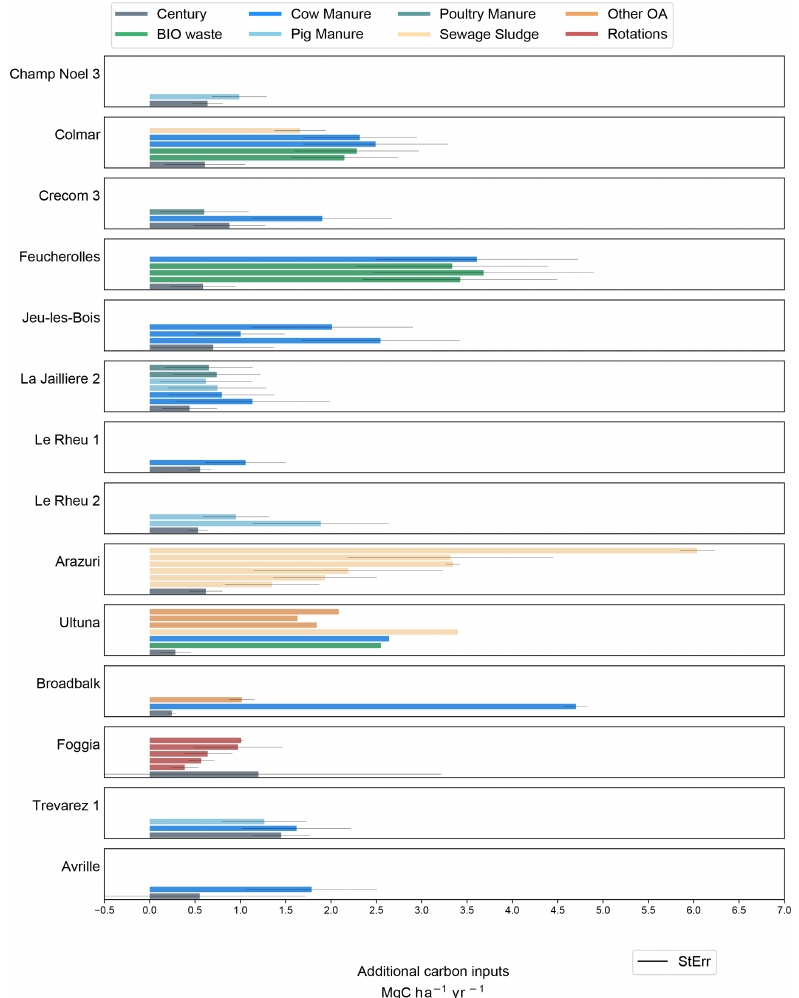
Figure 9. Additional modeled carbon inputs (MgCha − 1 yr − 1 ) to reach the 4p1000 (grey bars) compared to additional carbon input treatments (colored bars) at each experimental site. Additional carbon inputs for field trials are calculated as the sum of organic fertilizers and the delta carbon inputs from crop yields (compared to the control plot). Additional carbon treatments are separated into different categories: BIO waste: biowaste compost, green manure, green manure and sewage sludge, and household waste; Cow manure: cow manure and farmyard manure (in Broadbalk and Ultuna), pig manure, poultry manure, sewage sludge; Rotations: different crop rotations, other organic amendments (OA): straw, sawdust, and peat (in Ultuna) and castor meal (in Broadbalk). The error bars shown are the standard errors computed with the Monte Carlo